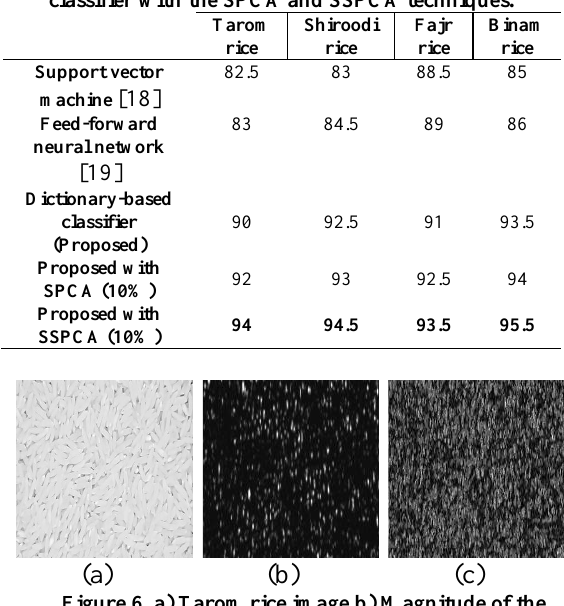
Table 2. Results of the classification rate for rice images based on the HOG feature for neural network, support vector machine, and proposed dictionary-based classifier with the SPCA and SSPCA techniques.